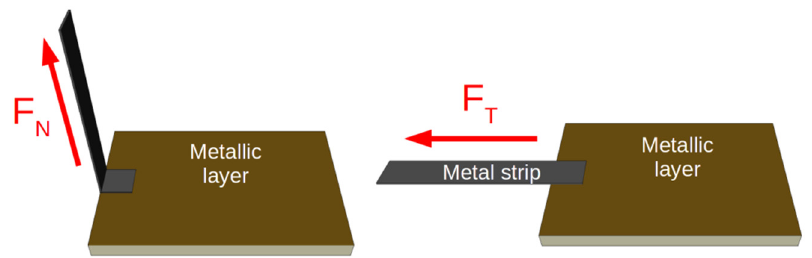
Figure 5. Configurations for strength testing of the joint.